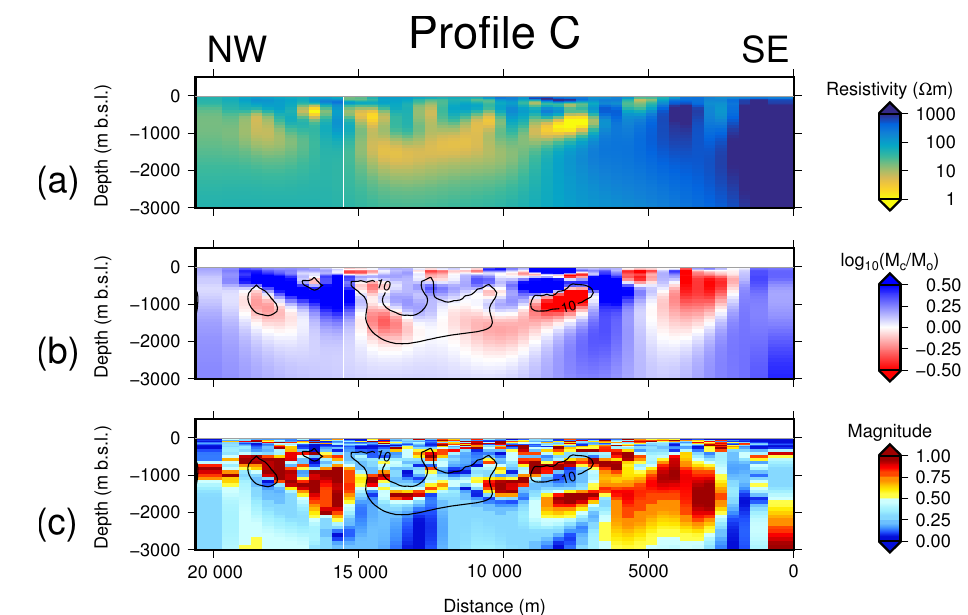
Figure 14. Profile C taken across the static-shift-corrected resistivity model M c (location shown in Figs. 1 and 11g). The resistivity is shown in panel (a) , the resistivity difference (cid:49)(M c ,M o ) is shown in panel (b) , and the cross-gradient of M c and M o is shown in panel (c) . Contours on the difference and cross-gradient plots show the 10 (cid:127) m contour. For presentation a vertical exaggeration of 1.5 is used.